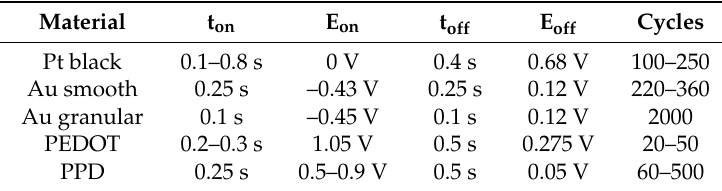
Table 1. Electrodeposition parameters for the different